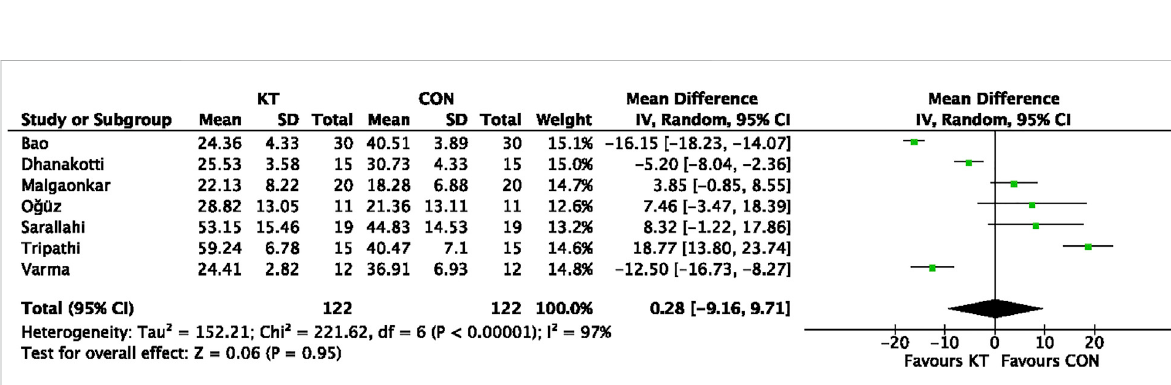
FIGURE 7 Forest plot of the meta-analyses comparing the KT group with control group for WOMAC score after intervention.